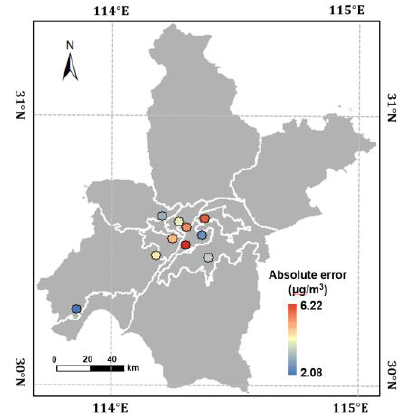
Figure 2. The absolute error of satellite PM2.5 estimation at each